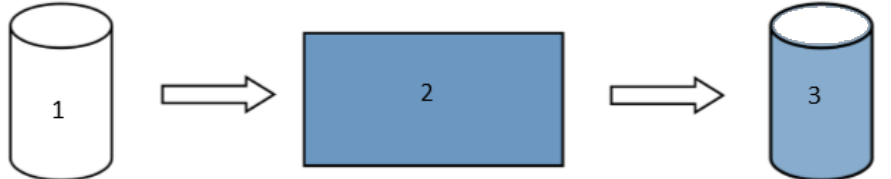
Figure 1. General scheme of implants coating. 1 —MD, EDW and blending implants obtained from electrospinning membranes; 2 —Polymeric films for coating composed by PCL and Lutrol F127 or Luwax EVA 3; 3 —final scheme of coated implants.